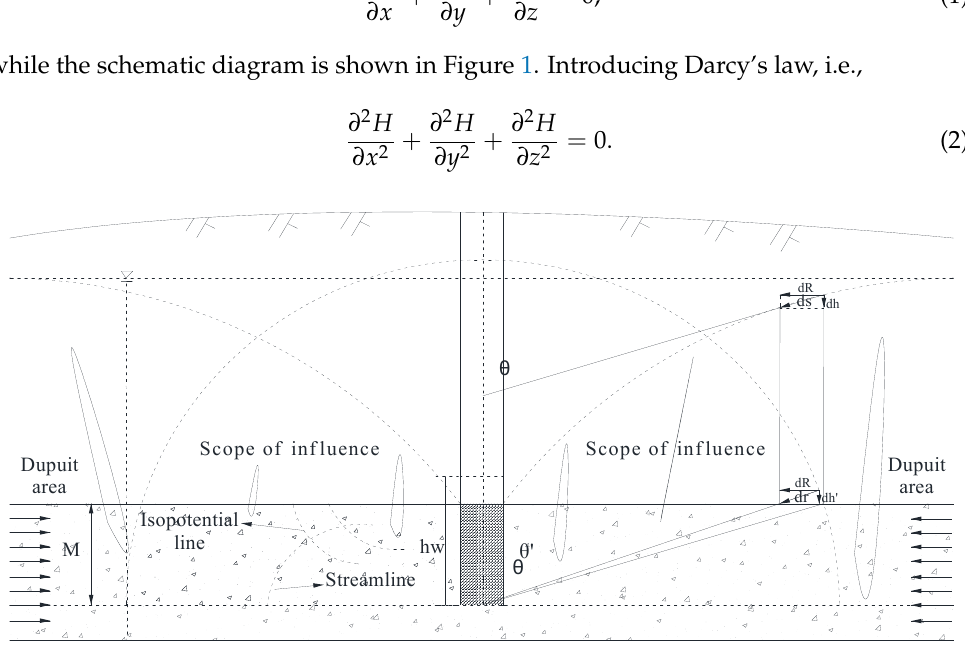
Figure 1. Mathematical model schematic.